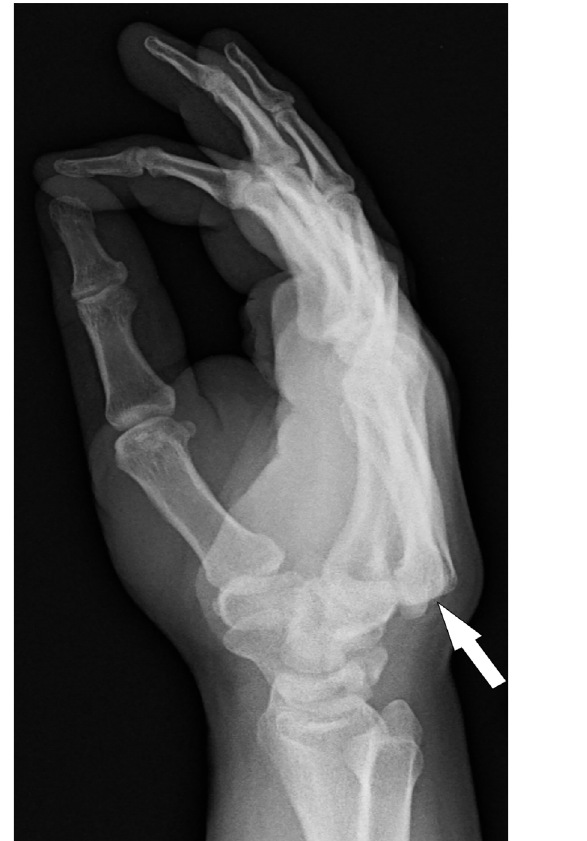
Image 2. Lateral view of the left wrist showing dorsal displacement of the proximal ends of the second through fifth metacarpals